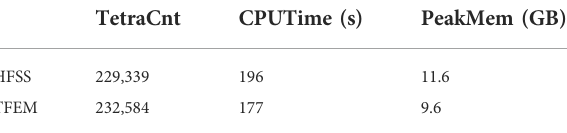
TABLE 2 Comparison of computational ef fi ciency between HFSS and the developed tool (TFEM). TetraCnt CPUTime